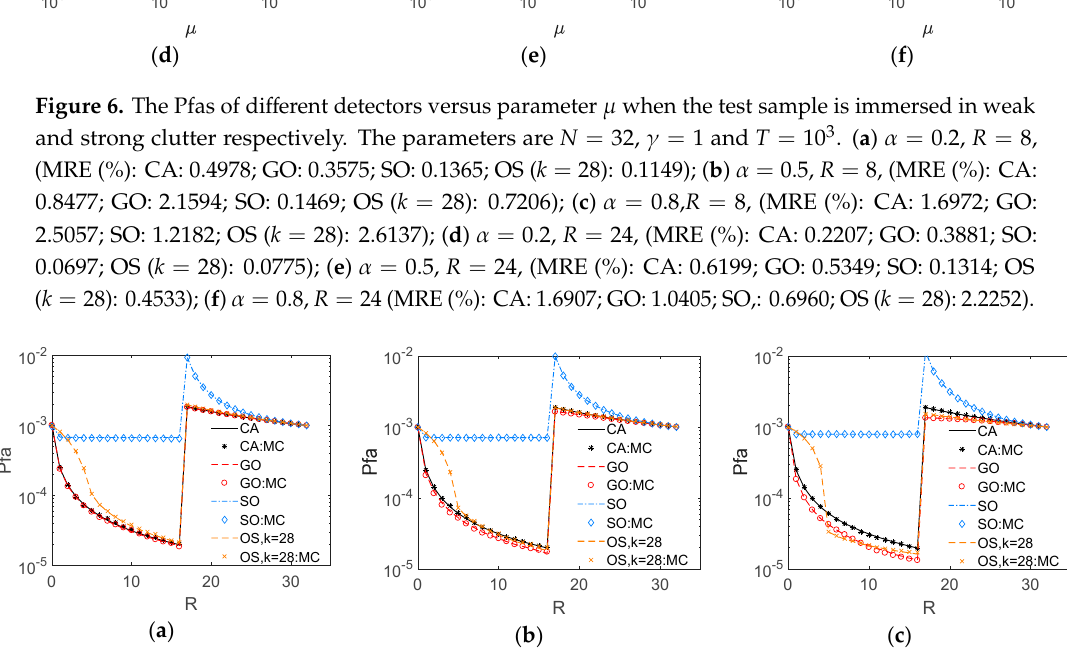
Figure 6. The Pfas of different detectors versus parameter μ when the test sample is immersed in weak and strong clutter respectively. The parameters are N = 32, γ = 1 and T = 10 3 . ( a ) α = 0.2, R = 8,